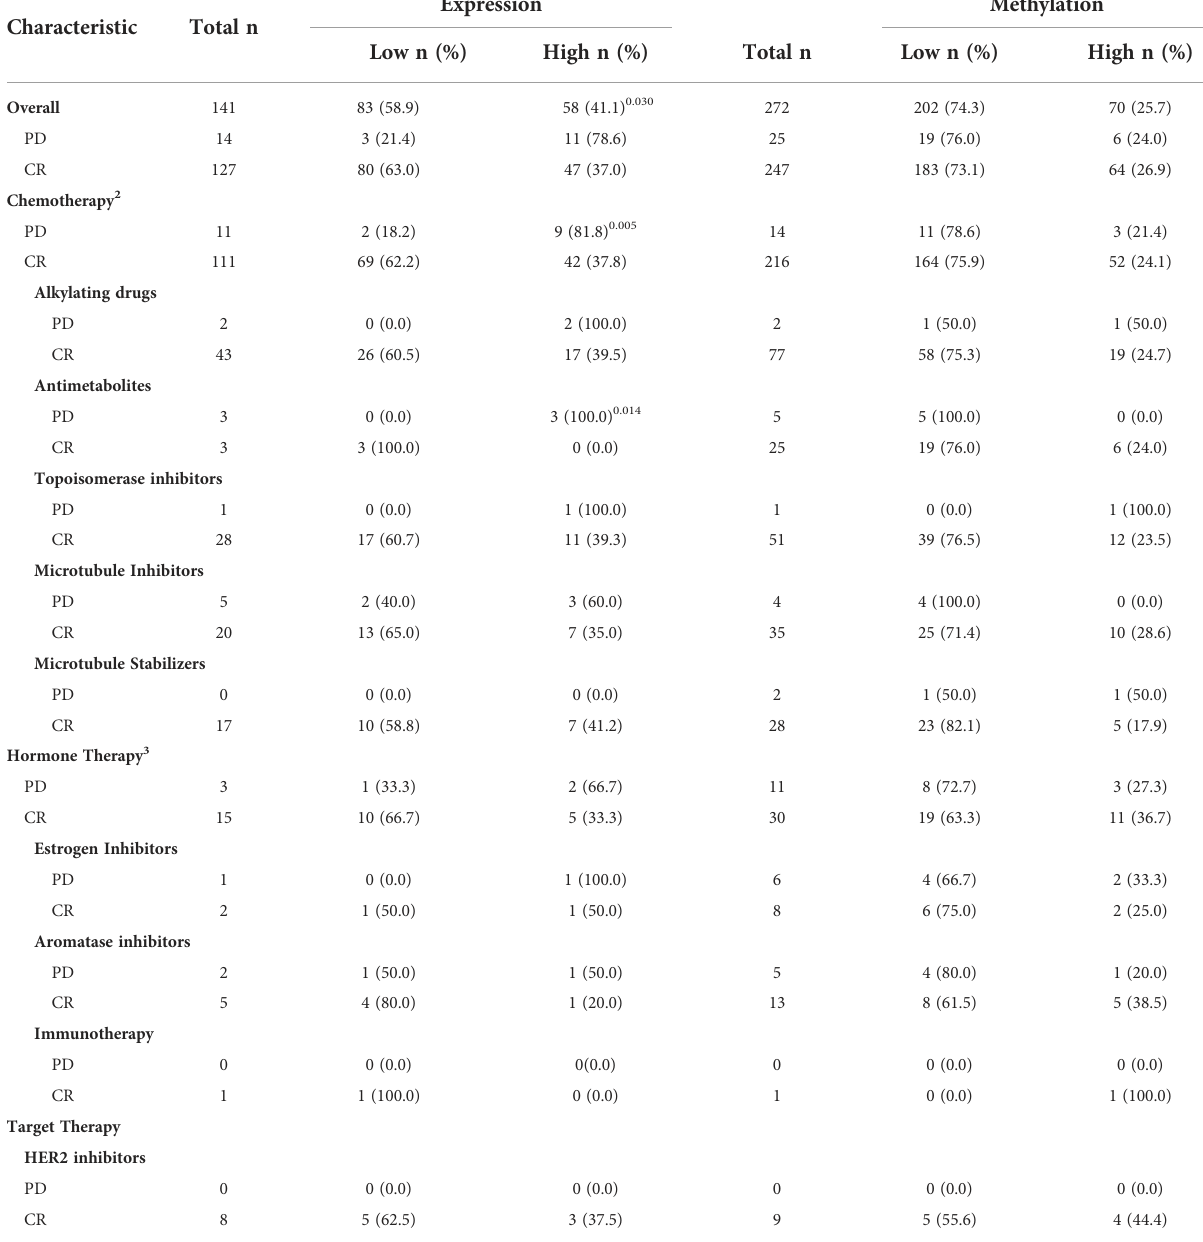
TABLE 4 TSTD1 mRNA expression and methylation level in relation to the drug response of Western breast cancer patients in TCGA datasets 1 .